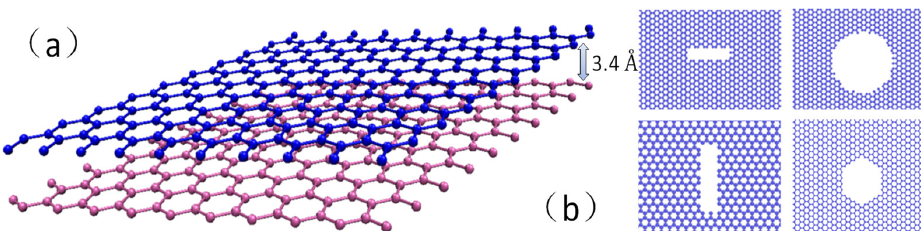
Figure 1. ( a ) Bilayer graphene with interlayer spacing 3.4 Å; ( b ) the shape of cracks on the graphene surface, including rectangular cracks, circular cracks, and Hexagonal cracks.